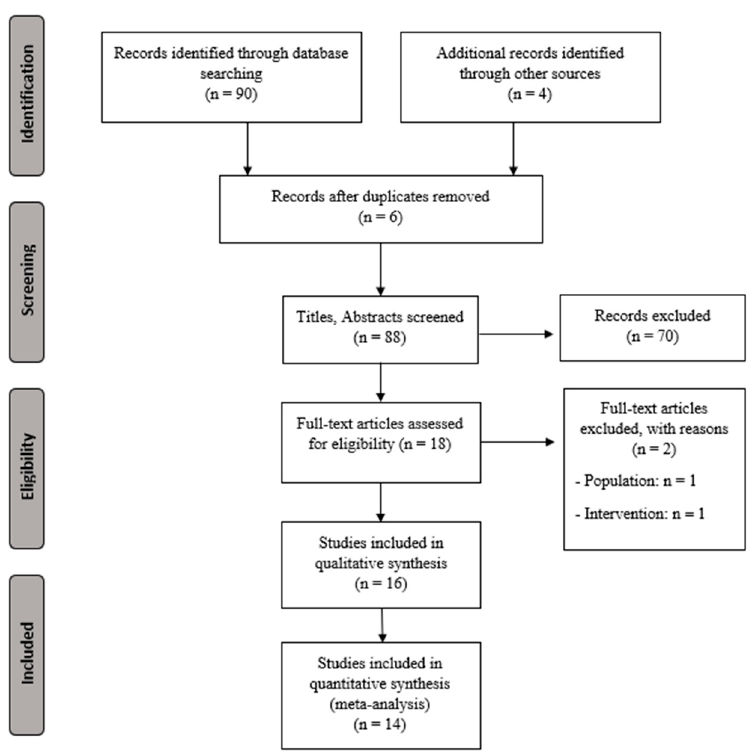
Figure 1. PRISMA flowchart for selecting studies. Table 1. Characteristics for the extracted data.